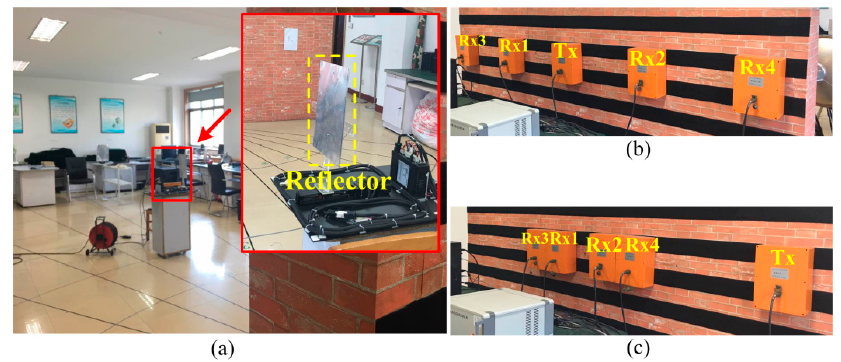
Figure 6. Measurement of the artificial breathing object: ( a ) photo of the object; ( b ) the multistatic UWB radar’s receiving antennas were separated from the transmitting one; ( c ) the transmitting antenna was moved away from the receiving ones.